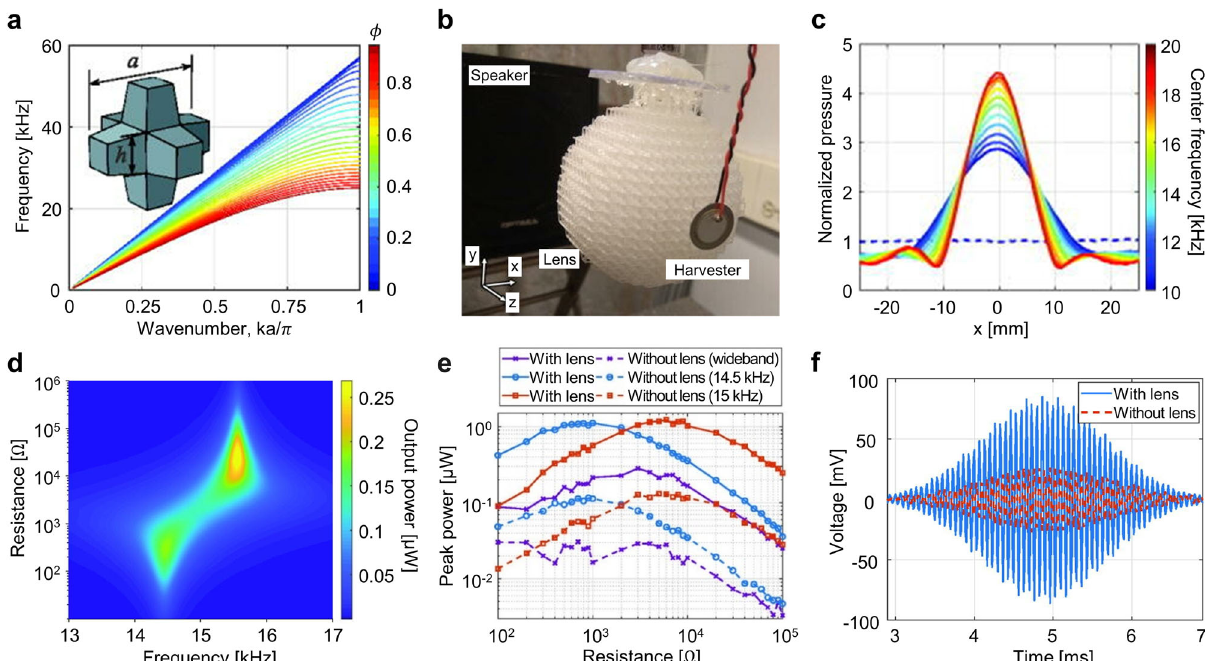
Fig. 9 3D-printed gradient-index (GRIN) lens for harvesting acoustic energy. a Unit cell and its band structure along the main direction of wave propagation for various volume- fi lling fractions, ϕ ¼ ð 3ah 2 (cid:2) 2 h 3 Þ = a 3 , where a is the lattice constant and h is the height of part of the unit cell depicted in fi gure. b Experimental setup to measure energy harvesting by piezoelectric devices. c Normalized pressure at different central frequencies, with a constant bandwidth of 6 kHz. d Output power vs frequency and resistance for a uniform harmonic pressure of 30 Pa. e Experimentally harvested peak power per resistance for an incident acoustic plane wave with a pressure of 30 Pa. f Numerical result of output voltage time series for maximum power output with and without GRIN lens 92 . Reprinted with permission from ref. 92